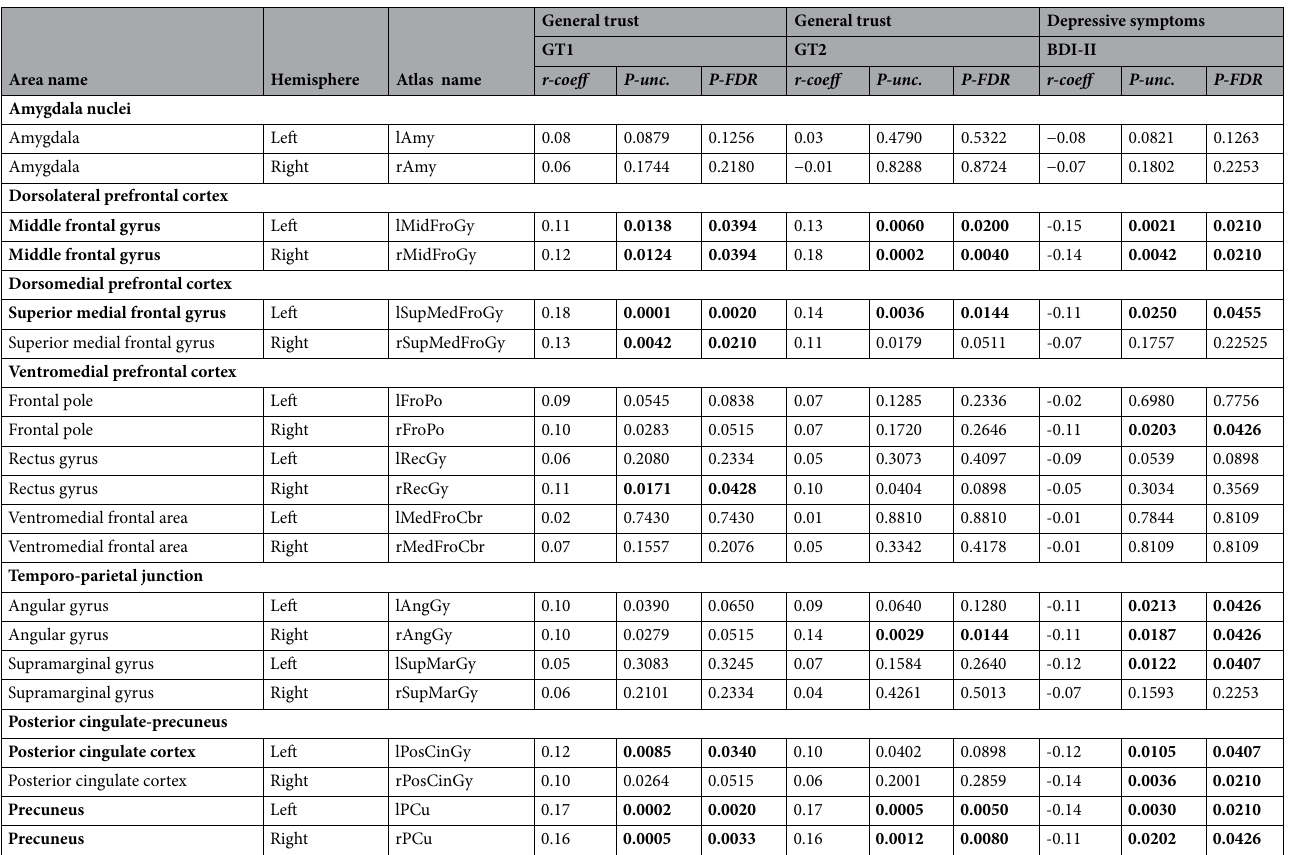
Table 1. Social brain regions linked with trust and depressive symptoms. Partial correlations showing the relationship between gray matter volume of social brain regions, trust and depressive symptoms. All analyses controlled for effects of age, sex, education, income and TIV. Brain regions with names highlighted in bold font are significantly associated with both trust and depressive symptoms. P-values in bold survived FDR